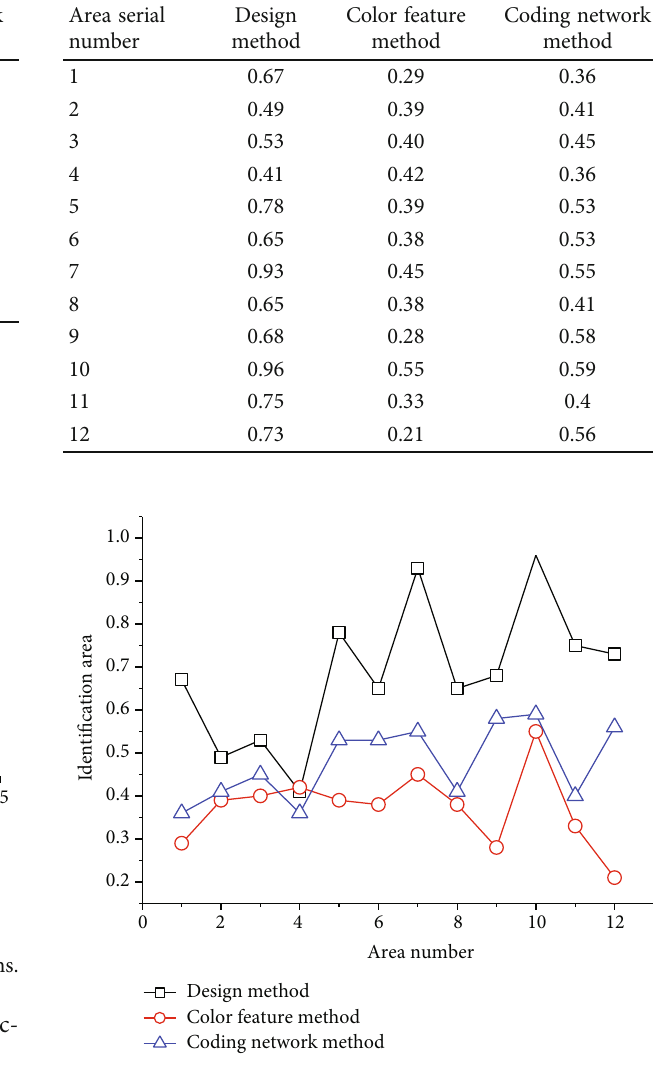
Figure 10: Comparison of identi fi cation range of di ff erent